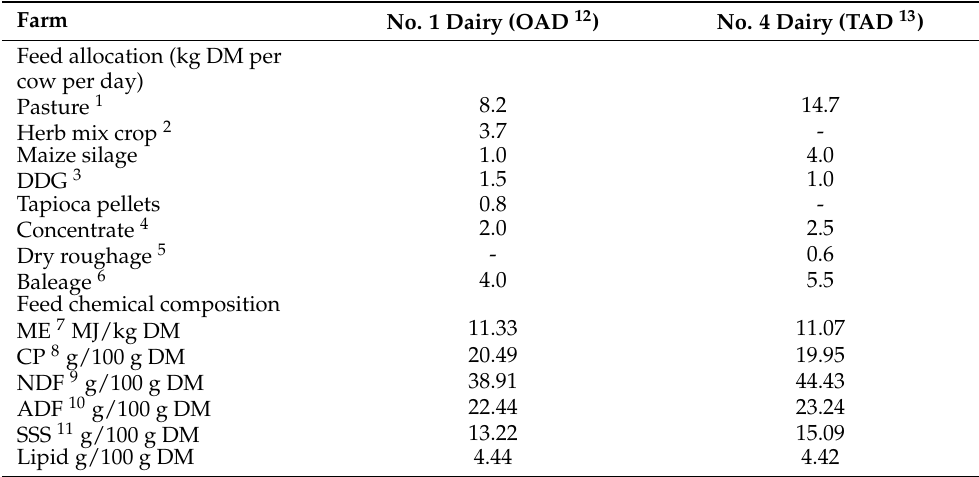
Table 1. Feed allocation and chemical composition of diet provided at the No. 1 Dairy and No. 4 Dairy during the sampling period in the milking season